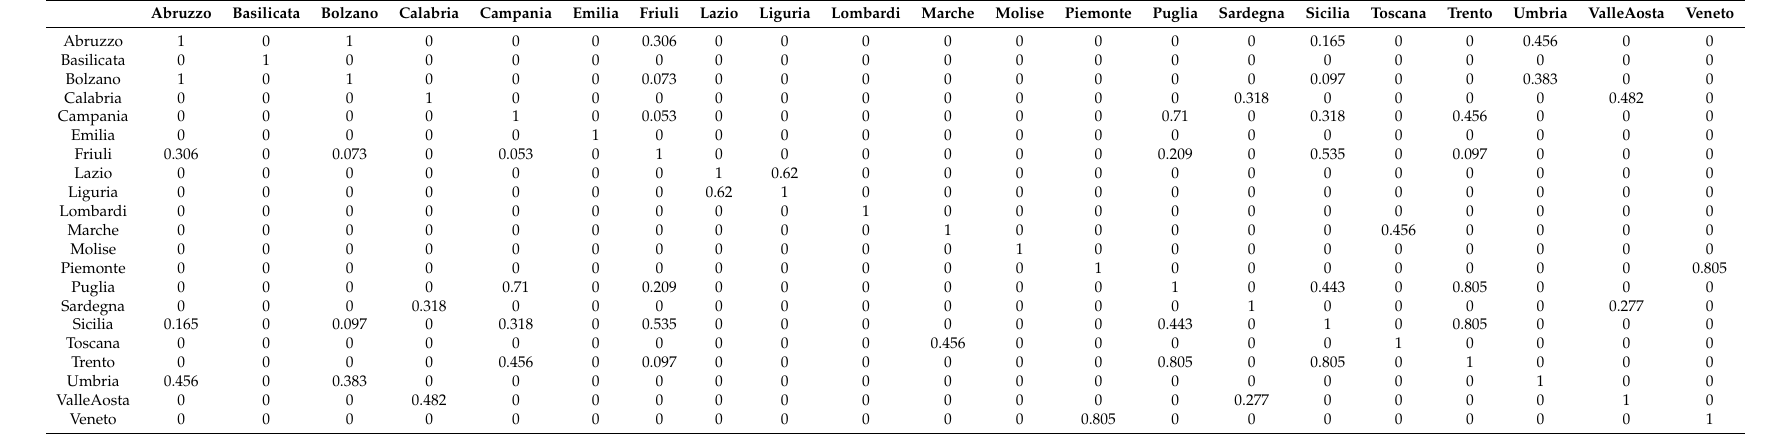
Table A30. Similarity values of Total Currently Positive network in the fifth